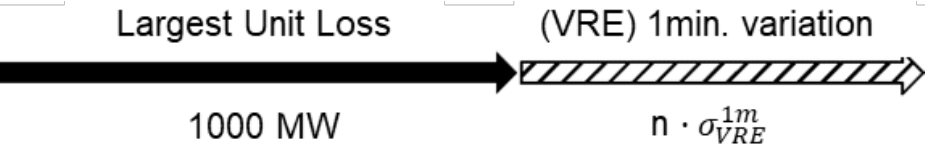
Figure 4. Primary reserve requirement for governor response.